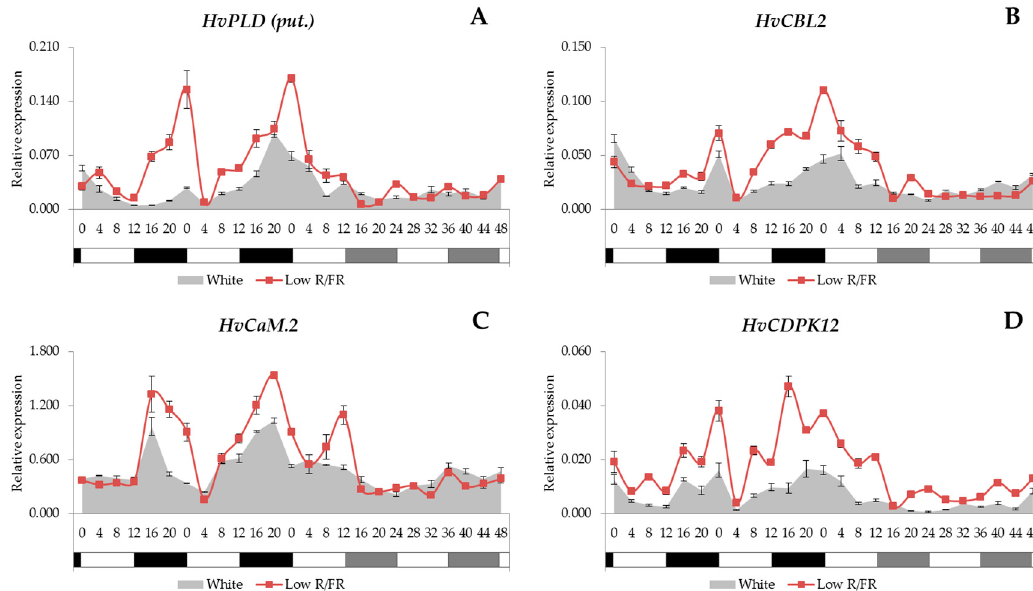
Figure 3. The expression patterns of the HvPLD (put.) , HvCBL2 , HvCaM.2 , HvCDPK12 ( A – D ) with white light and low R/FR illumination. Conditions are the same as in Figure 1.